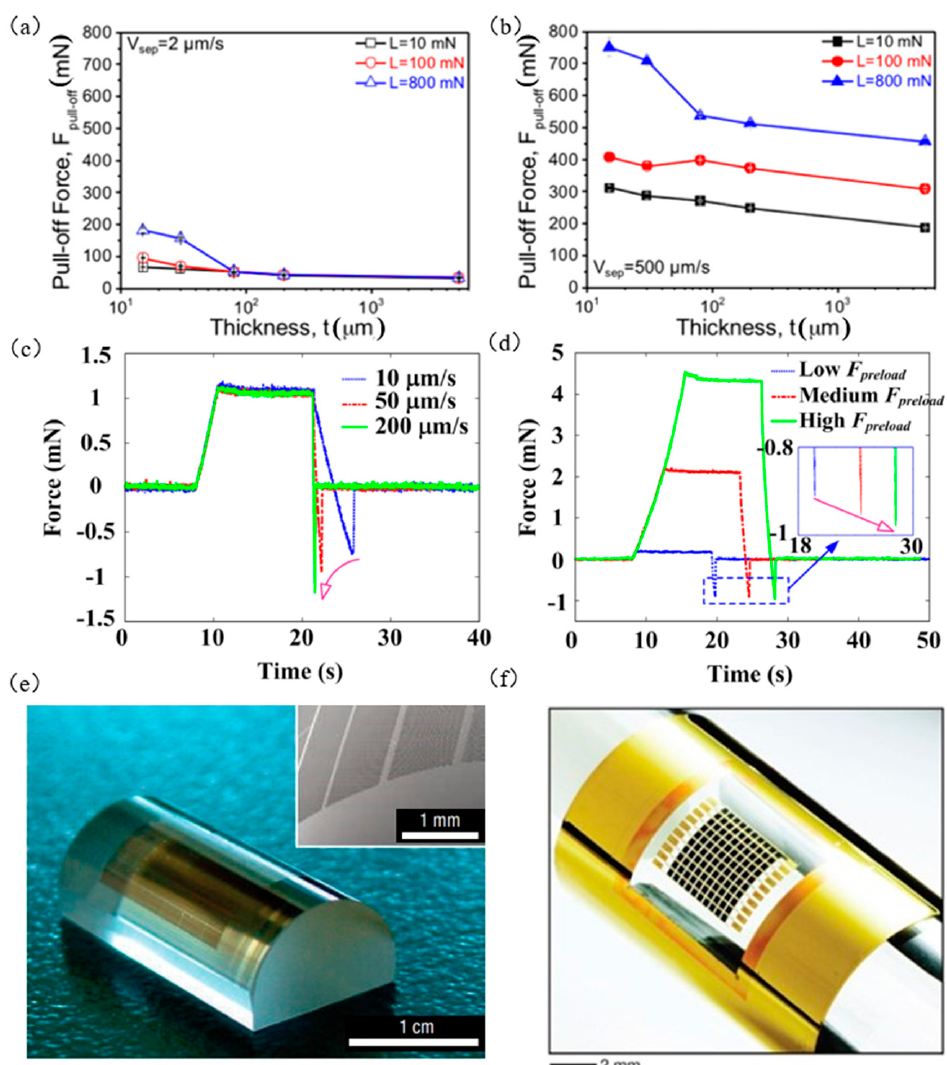
Figure 5. Kinetic transfer printing principles and examples. ( a , b ) The relationship between the thickness of the seal and the tensile force under different contact loads at different peeling speeds (reproduced from [80]), ( c ) the relationship between the pulling force and the peeling speed (reproduced from [70]), ( d ) the relationship between tension and preload (reproduced from [70]), ( e ) printed array formed on cylindrical glass lens (reproduced from [48]), and ( f ) flexible gallium arsenide solar cell array (reproduced from [86]).